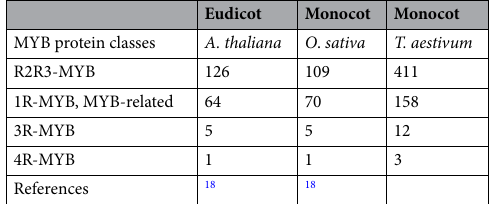
Table 1. Classes of MYB TFs in A. thaliana , O. sativa , and T. aestivum .